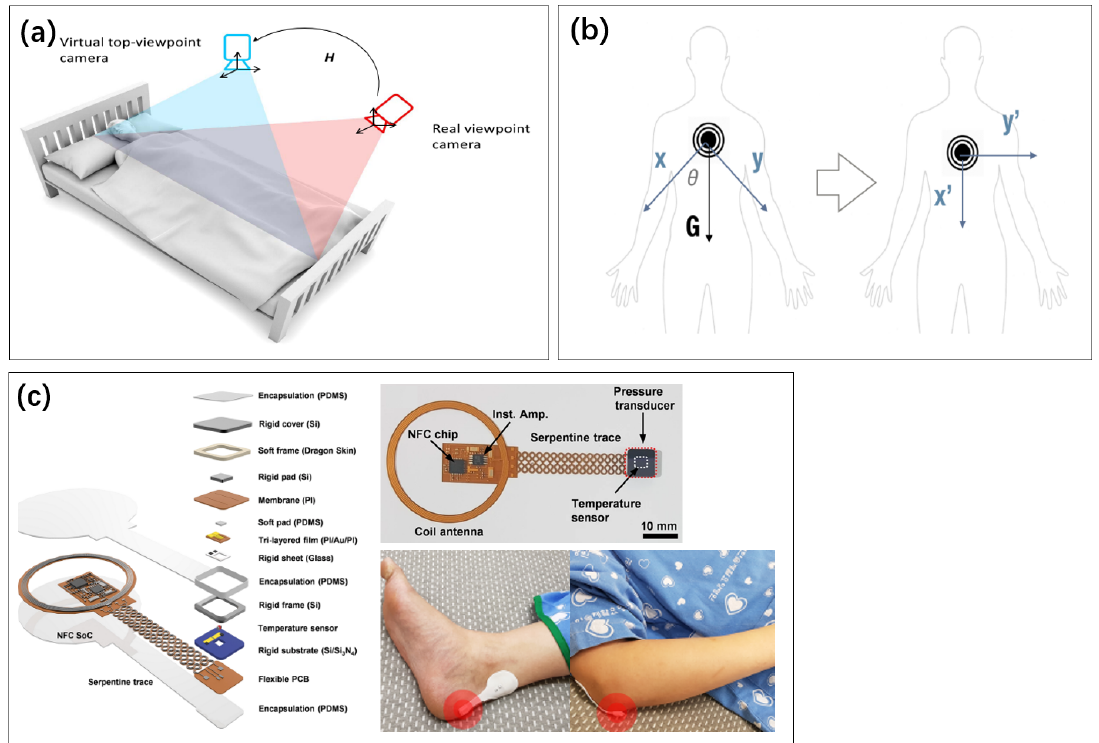
Figure 11. ( a ) Camera images used to analyze sleep posture [5]. Reproduced under the terms of the CC-BY Creat ive Commons Attribution License, Copyright 2019 by the authors, published by Inst